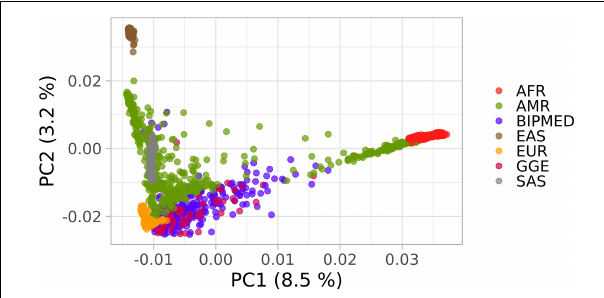
FIGURE 1 | Principal component analysis (PCA) plot of the Brazilian samples and 1000 Genomes Project (1KGP) dataset. The x -axis and y -axis show the first and second principal components (PC1 and PC2) and their respective percentage variability. Each point represents one individual and each color indicates patients with genetic generalized epilepsy (GGE), BIPMed controls, and the continental populations described in 1KGP. as follows: